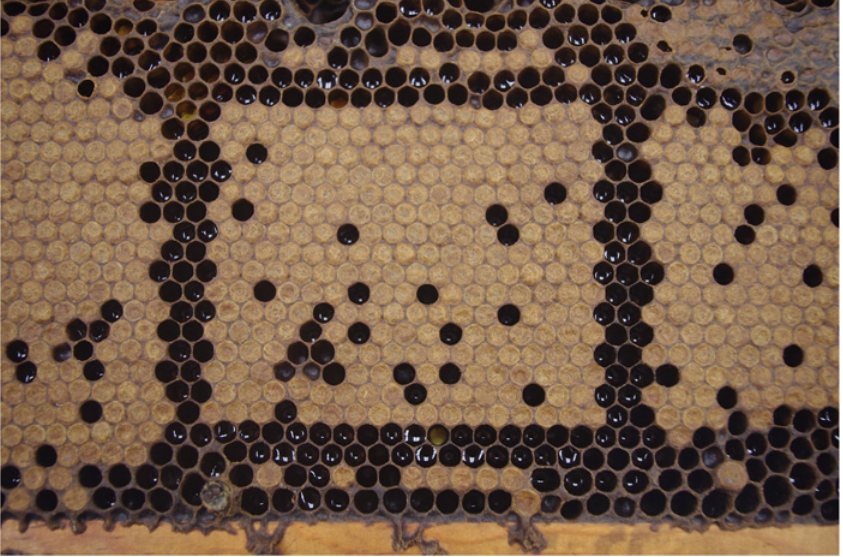
Fig 1. A small brood section of 238 cells created within an infested donor